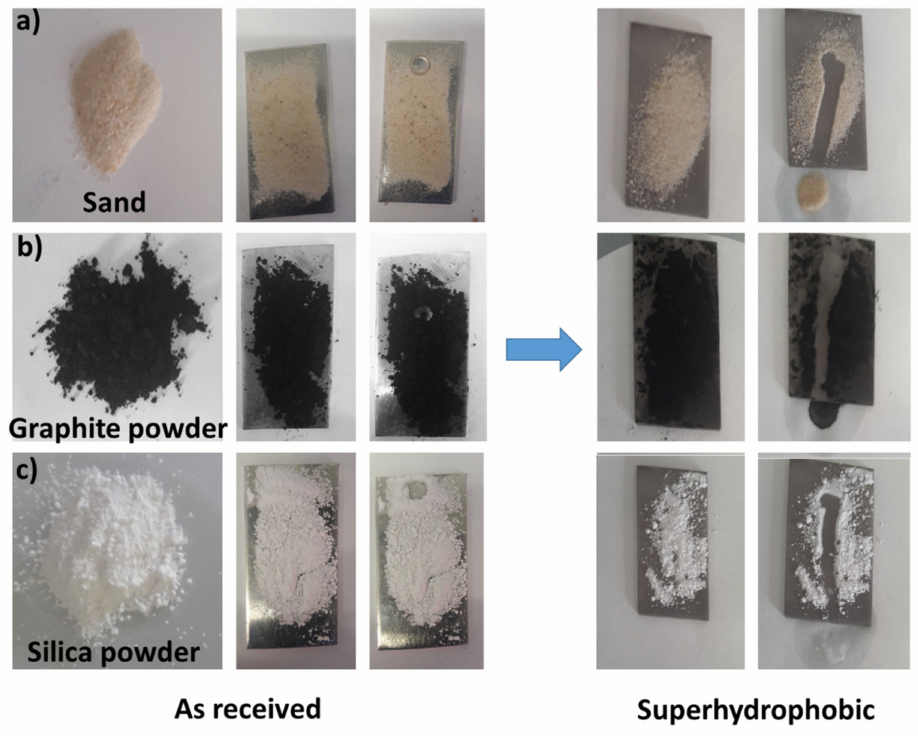
Figure 8. The self-cleaning behavior of the superhydrophobic Al-FS surface using different con- taminants: ( a ) sand, ( b ) graphite powder, and ( c ) silica powder. On the left side of the picture, the behavior of the as-received (untreated) aluminum surface is shown as